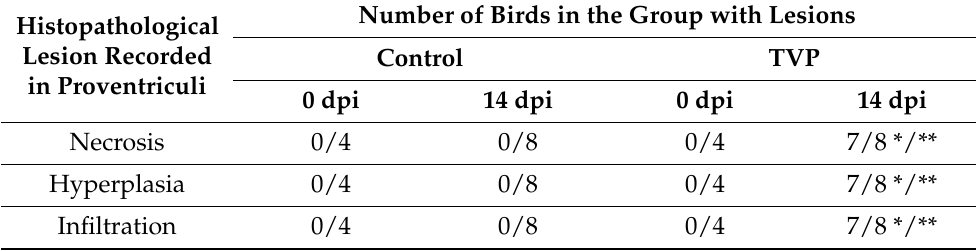
Figure 2. Histopathological lesions. Left—histopathological lesions typical for transmissible viral proventriculitis were recorded in 7 out of 8 examined proventriculi of birds from TVP group. The lesions concerned necrosis of glandular epithelium (black arrows), hypertrophy and hyperplasia of ductal epithelium (white arrow), replacement of glandular epithelium by hyperplastic ductal epithelium (white arrowhead) and infiltration of lymphoid cells (star) ( A ). Right—histological image of a control bird ( B ). Table 3. Prevalence of histopathological lesion in birds of TVP and Control